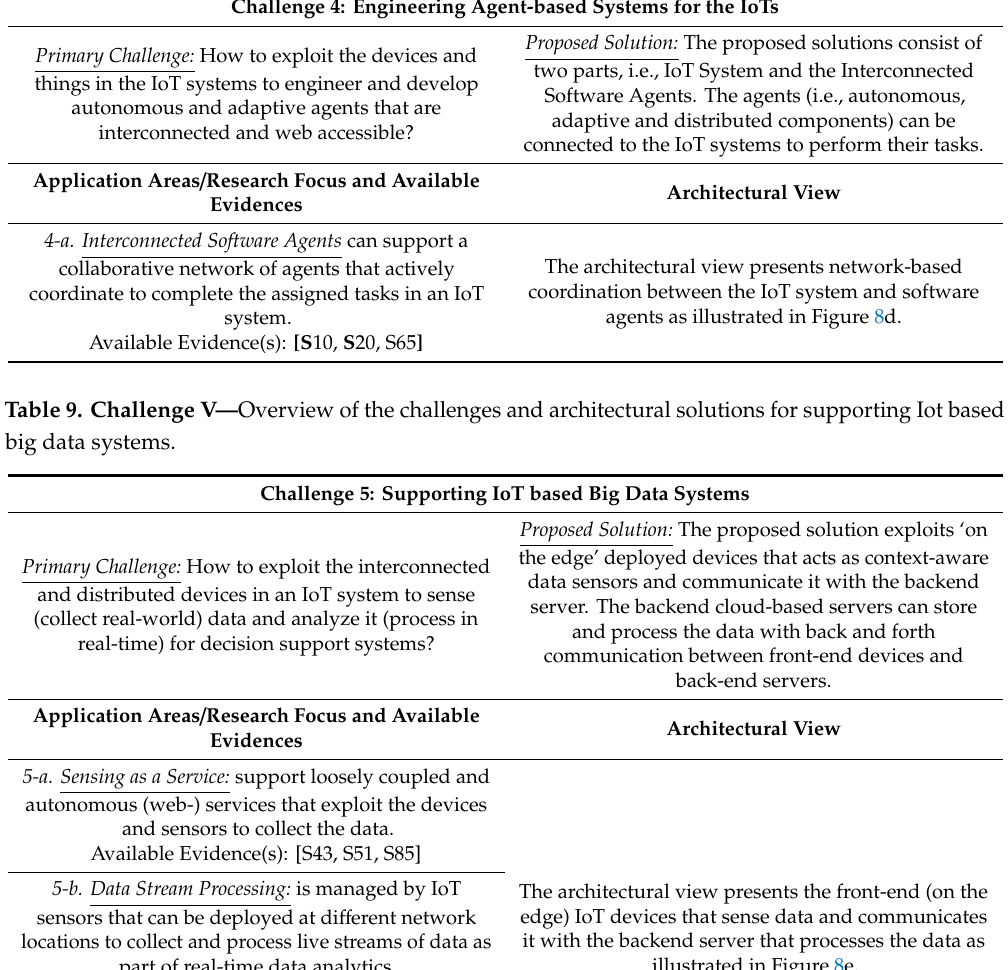
Table 8. Challenge IV— Overview of the challenges and architectural solutions for engineering agent-based systems for IoTs.